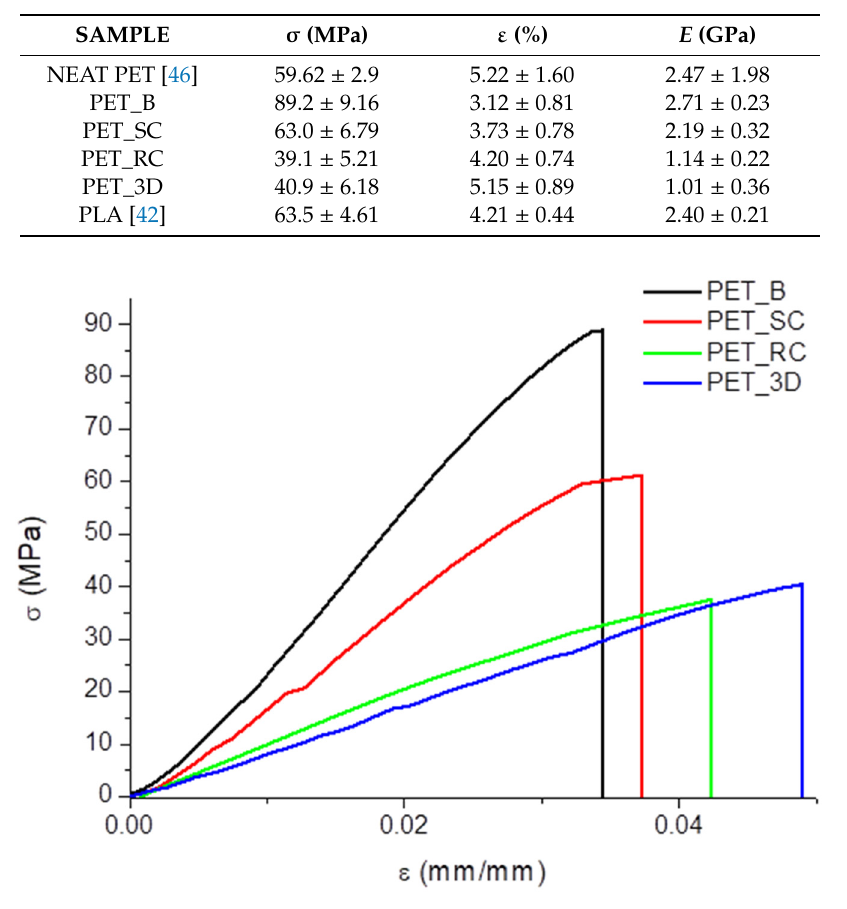
Figure 7. Stress-strain average curves. Table 4. Mechanical properties of PET samples.